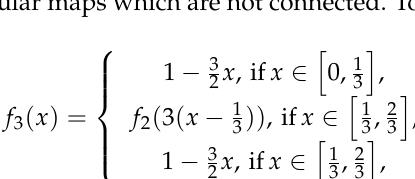
corresponding to f = T 2 , the second iterate of the tent map. f